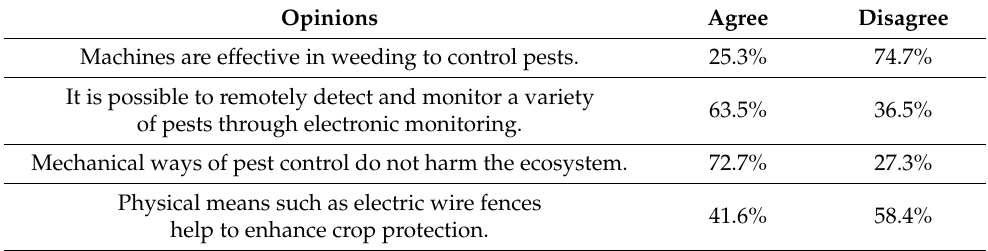
Table 7. Showing opinions concerning aspects of sustainable agricultural productivity. Opinions Agree Disagree 63.7% 36.3% 57.1% 42.9%